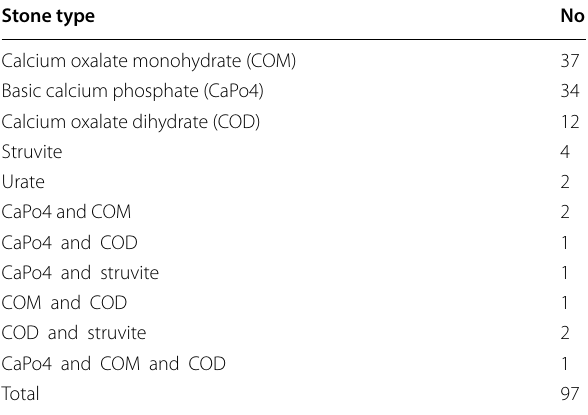
Table 2 Relation between density of the stone in HU, size of the stone, and its PKUB findings